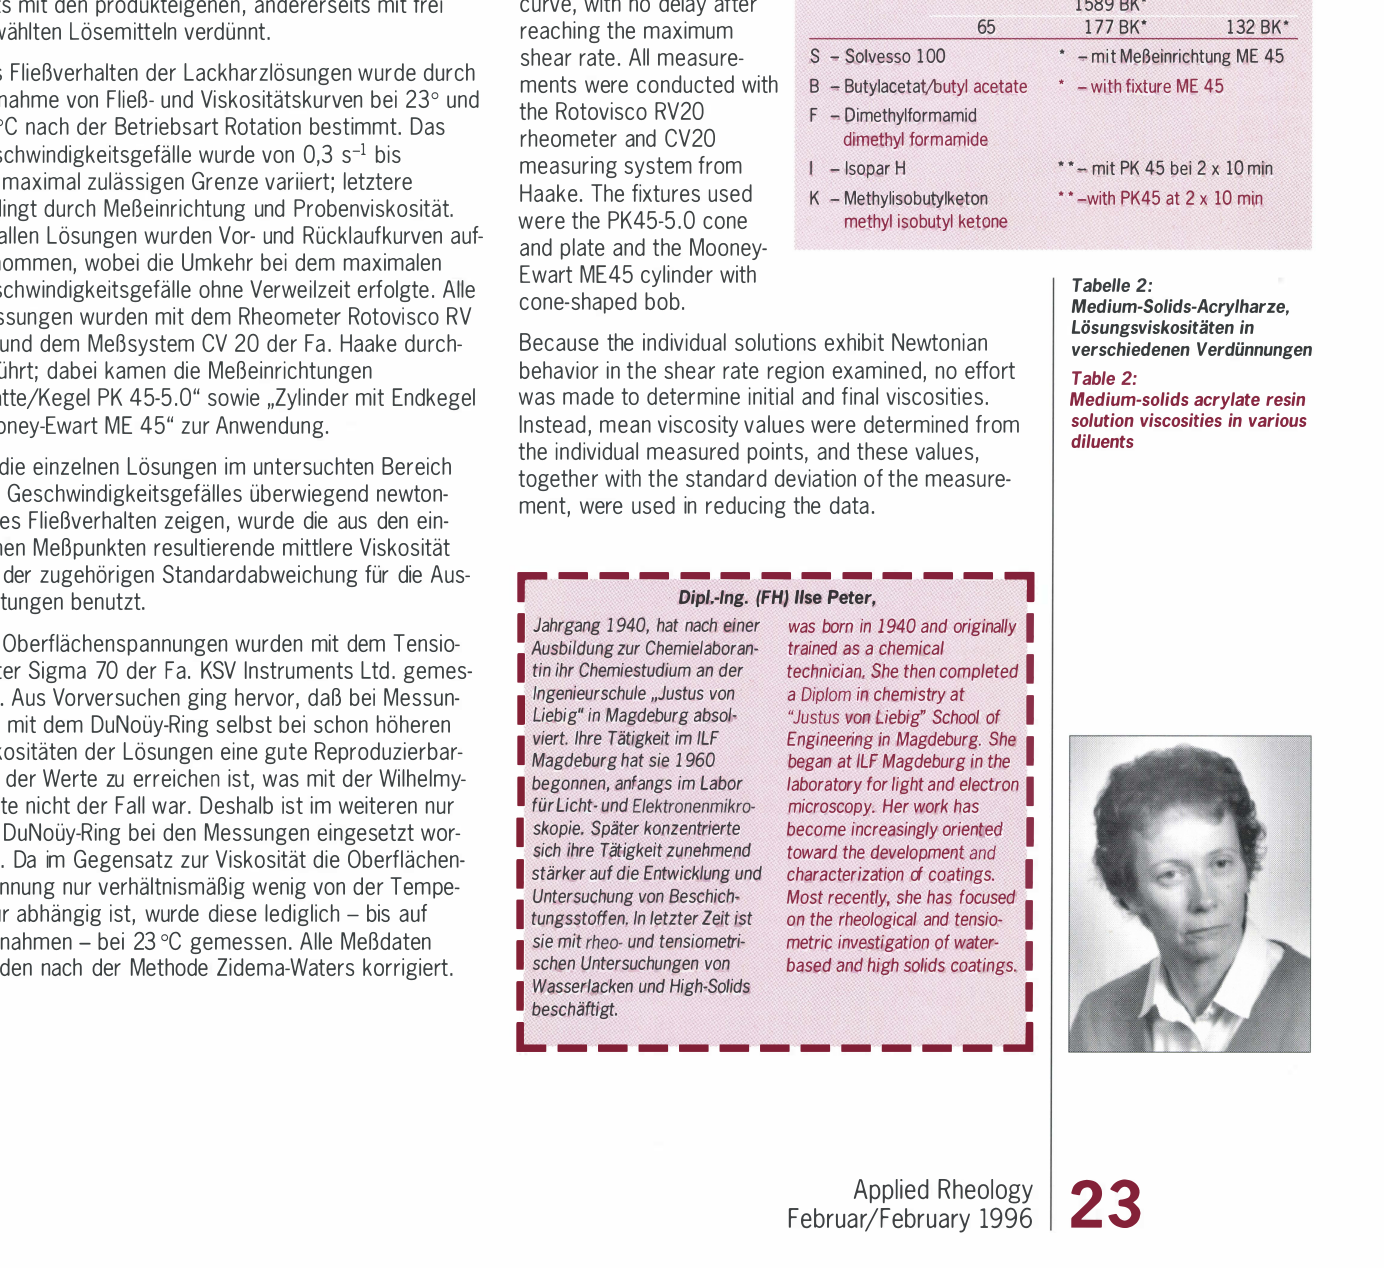
Tabe//e 2: Medium-Solids-Acrylharze,